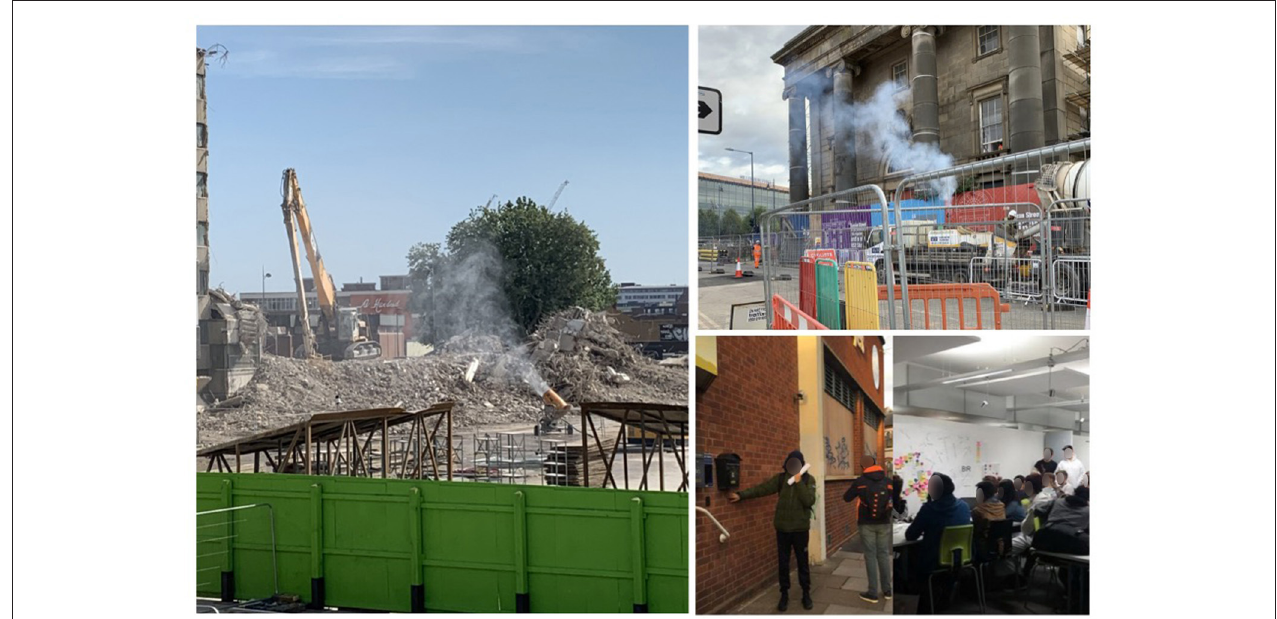
FIGURE 1 | Reading the smells in various sites in the Digbeth area in the city of Birmingham,